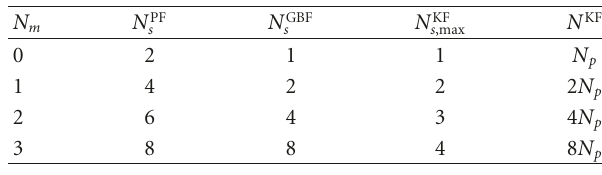
Table 2: Complexity of TFMBF depending on N m .